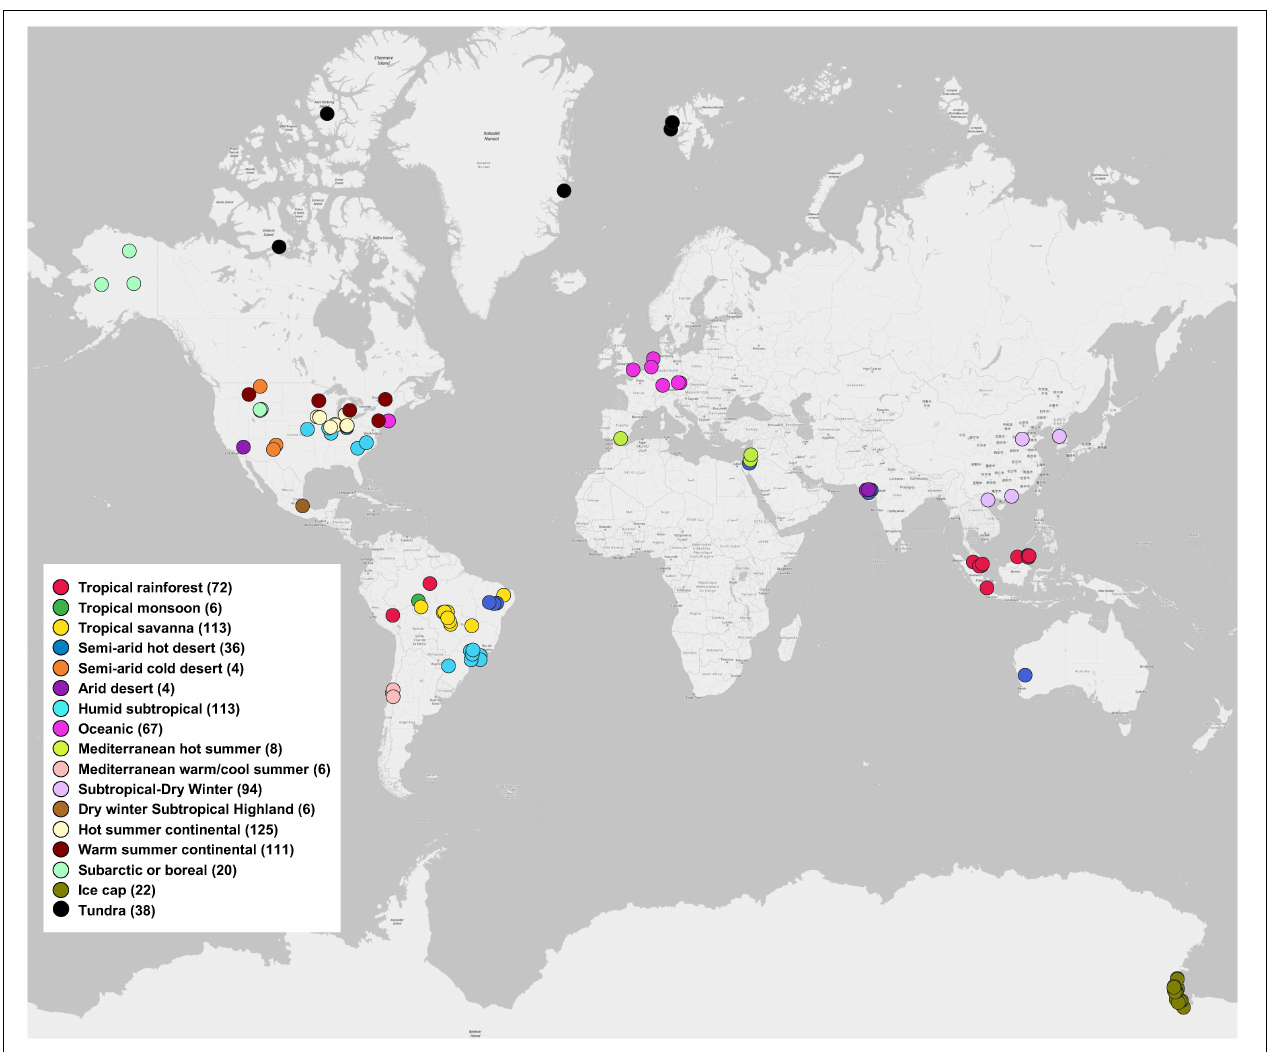
FIGURE 1 | Global distribution of 845 soil metagenomes. Locations are grouped by 17 climate zones from 51 publications used in this study. Sample sizes of each climate zone classification are given in